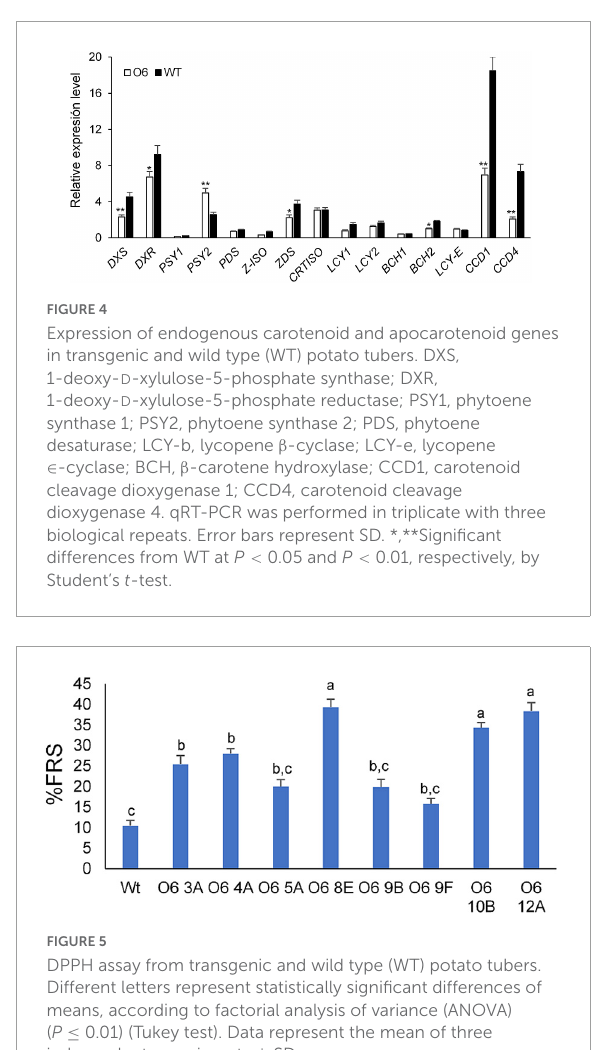
FIGURE5 DPPH assay from transgenic and wild type (WT) potato tubers. Different letters represent statistically significant differences of means, according to factorial analysis of variance (ANOVA) ( P ≤ 0.01) (Tukey test). Data represent the mean of three independent experiments ±